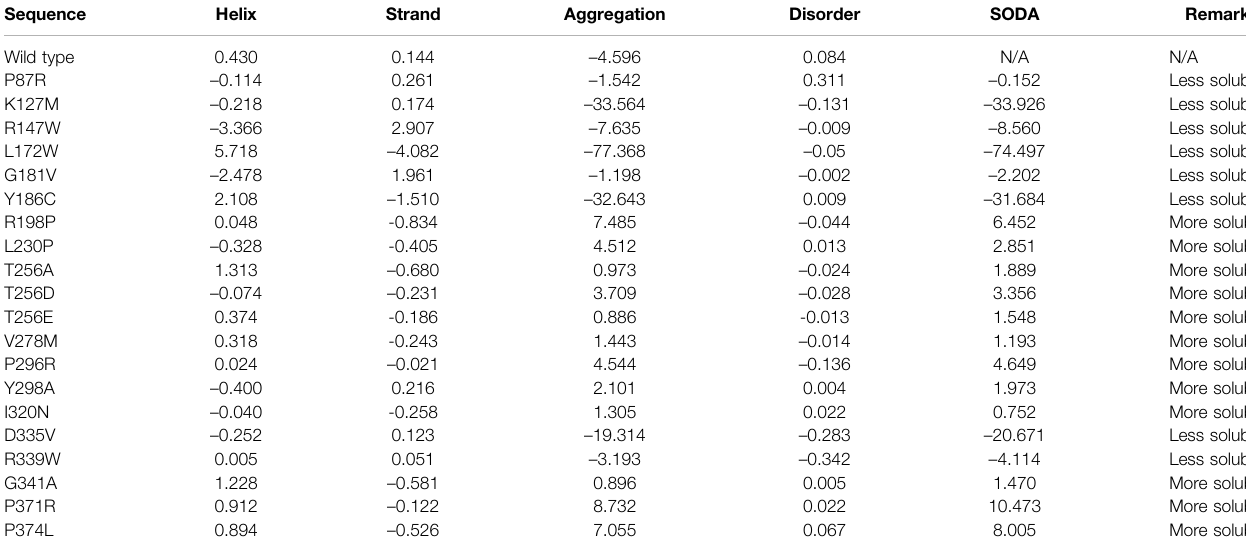
TABLE 1 | Aggregation propensity of SGK1 mutant proteins predicted through SODA.